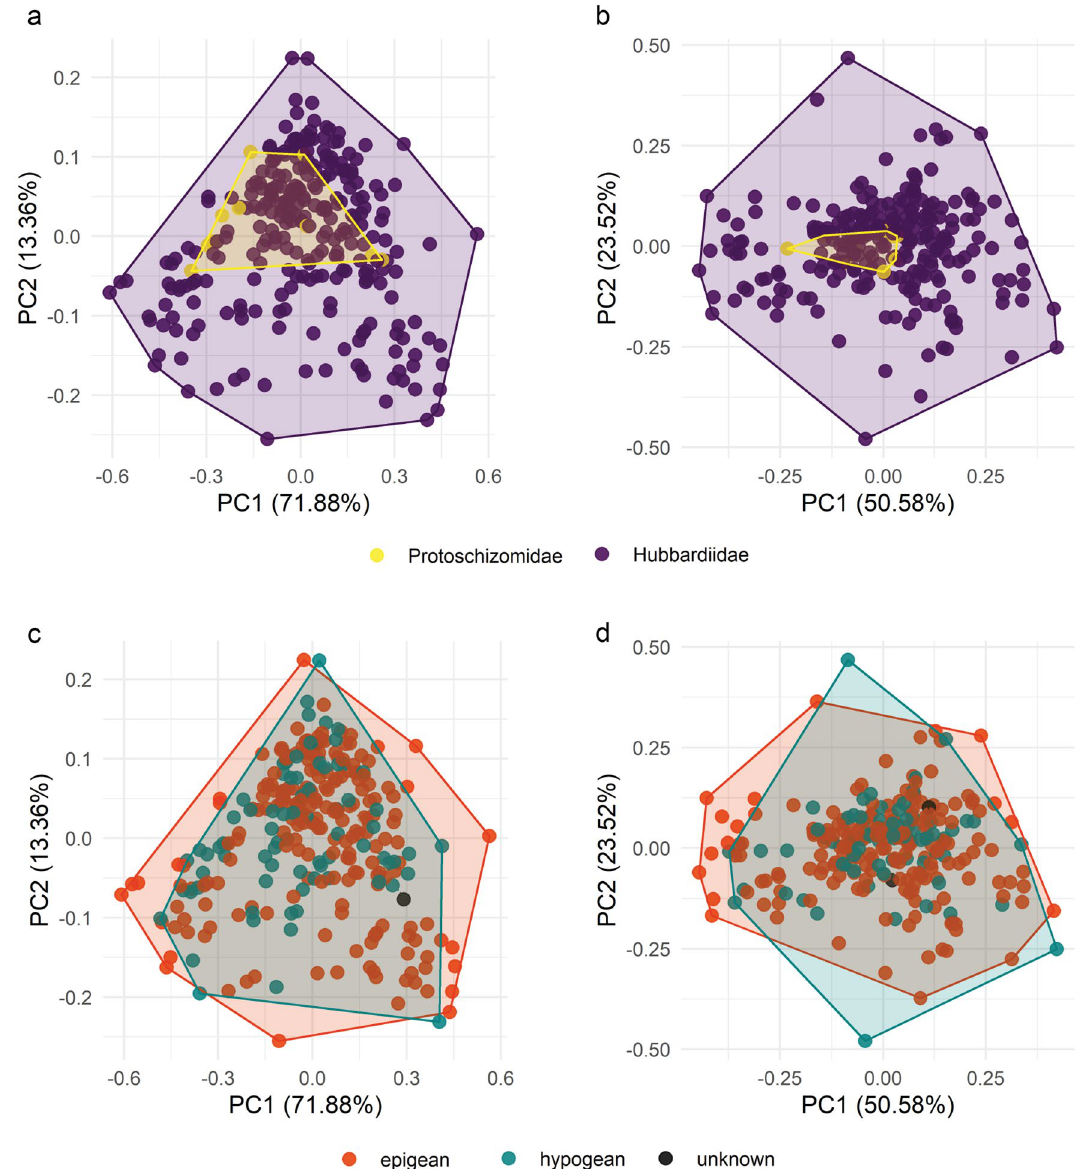
Figure 3. Morphospace plots based on male schizomid flagella. ( a ) Categorized by family, dorsal view. ( b ) Categorized by family, lateral view. Legend: Protoschizomidae, yellow; Hubbardiidae, violet. ( c ) Categorized by habitat, dorsal view. ( d ) Categorized by habitat, lateral view. Legend: epigean, red; hypogean: teal; unknown,